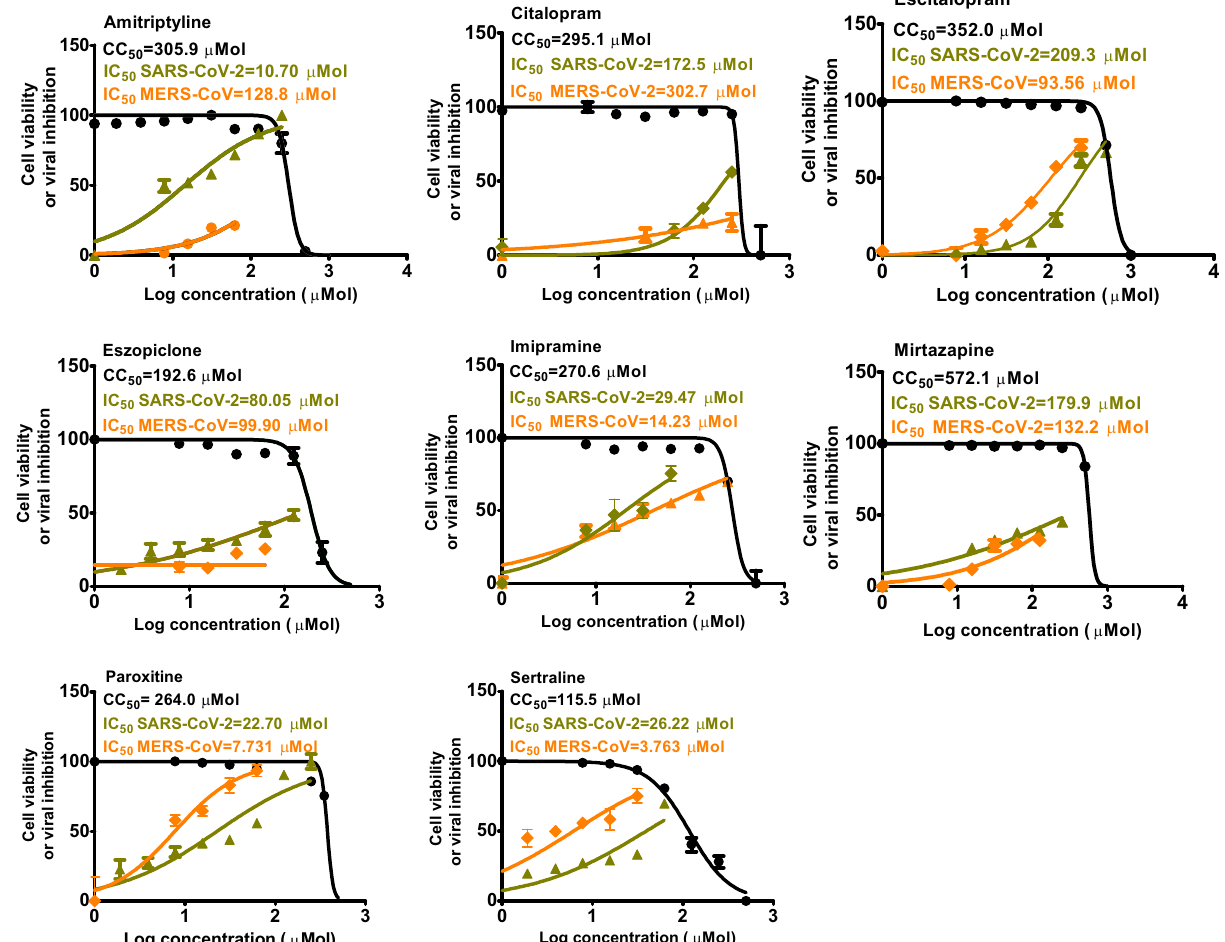
Figure 2. Determination of cytotoxic 50% (CC 50 ) of selected antidepressants in Vero-E6 cells and inhibitory concentration 50% (IC 50 ) of selected antidepressants against NRC-03-nhCoV in Vero-E6 cells and inhibitory concentration 50% (IC 50 ) of selected antidepressants against NRCE-HKU270 in Vero-E6 cells. The CC 50 and IC 50 values were calculated using nonlinear regression analysis of GraphPad Prism software (version 5.01) by plotting log inhibitor versus normalized response (variable